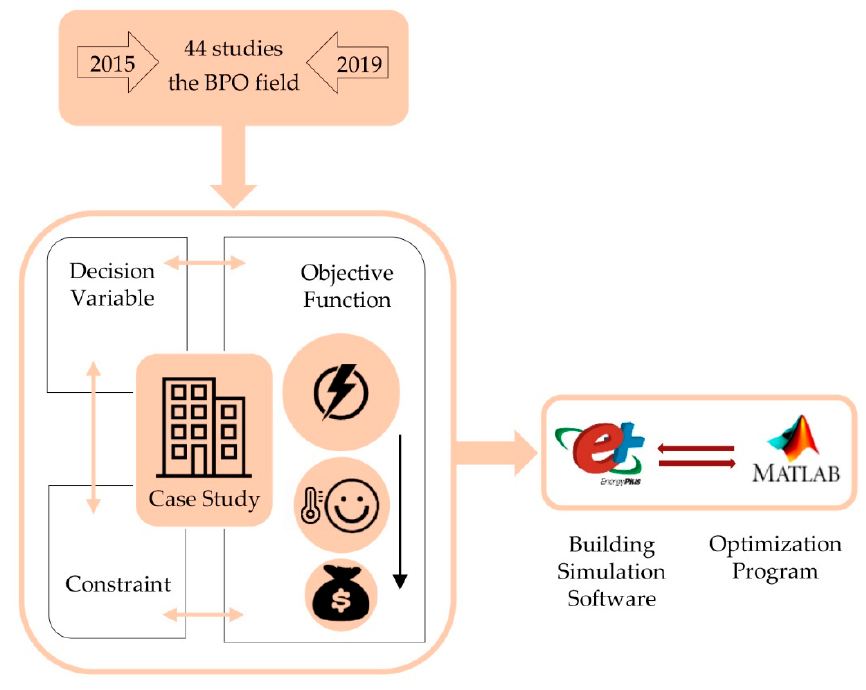
Figure 13. The graphical description of the work.